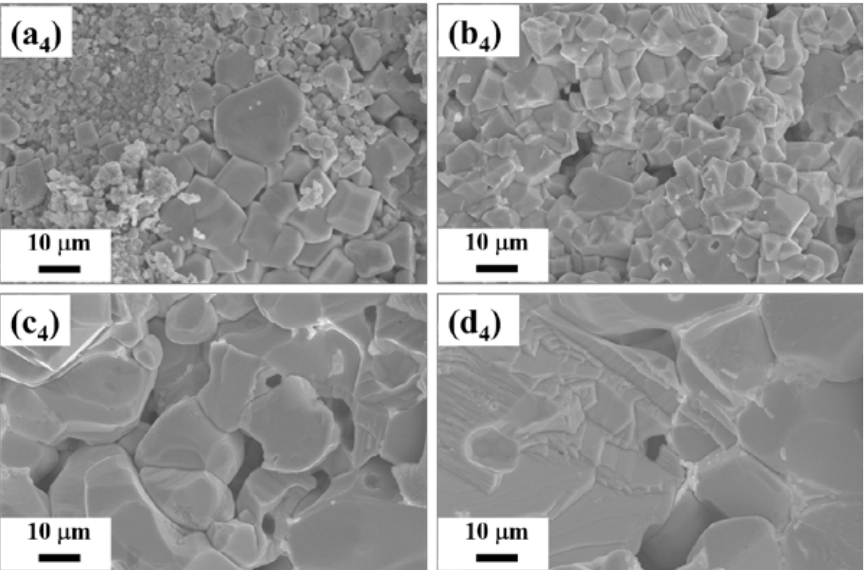
Figure 2. SEM images of fracture of the samples ( a 4 ) x = 0, ( b 4 ) x = 0.01, ( c 4 ) x = 0.03, and ( d 4 ) x = 0.05 (SS-series) after annealing (before grinding). All micrographs are taken at the same magnification. The EDX images and tables of the elemental composition of the samples show that gallium is not evenly distributed across the samples. A large amount of gallium is observed at the grain boundaries, which indicates the possibility of the formation of the CsGaI 4 phase. Since CsGaI 4 is an ionic liquid and remains in a liquid state at a temperature of 300 ◦ C, it becomes an ion exchanger (or solvent) between precursors/Cs 2 SnI 6 , and this is the